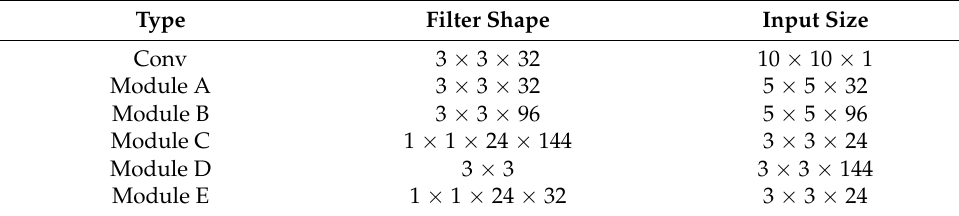
Figure 3. Classification model of the proposed LMNet. Table 1. Lightweight MobileNet body architecture.